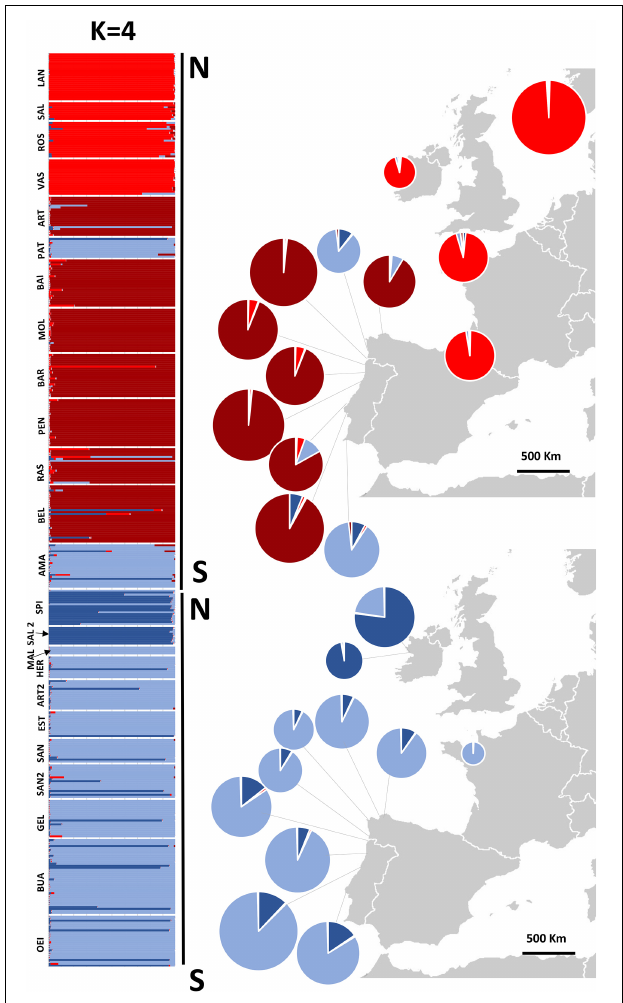
FIGURE 5 | Structure assignment of individuals to 4 inferred clusters and pie charts of combined genetic ancestries of all individuals sampled in each population. Pie charts on the right give the mean ancestry estimates for each population across 10 replicates. Population codes in Table 1